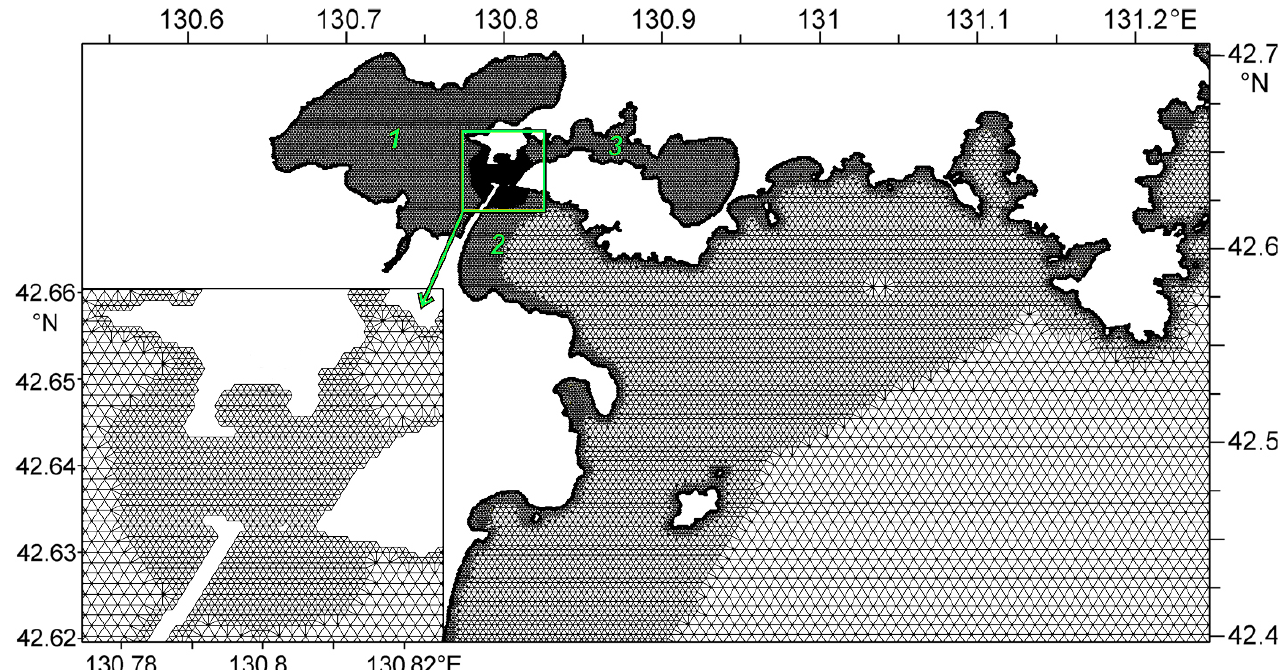
Figure 2. Posyet Bay with adjacent areas as resolved by numerical model. The digits indicate: 1—Expedition, 2—Reyd Pallada, 3—Novgorodskaya.